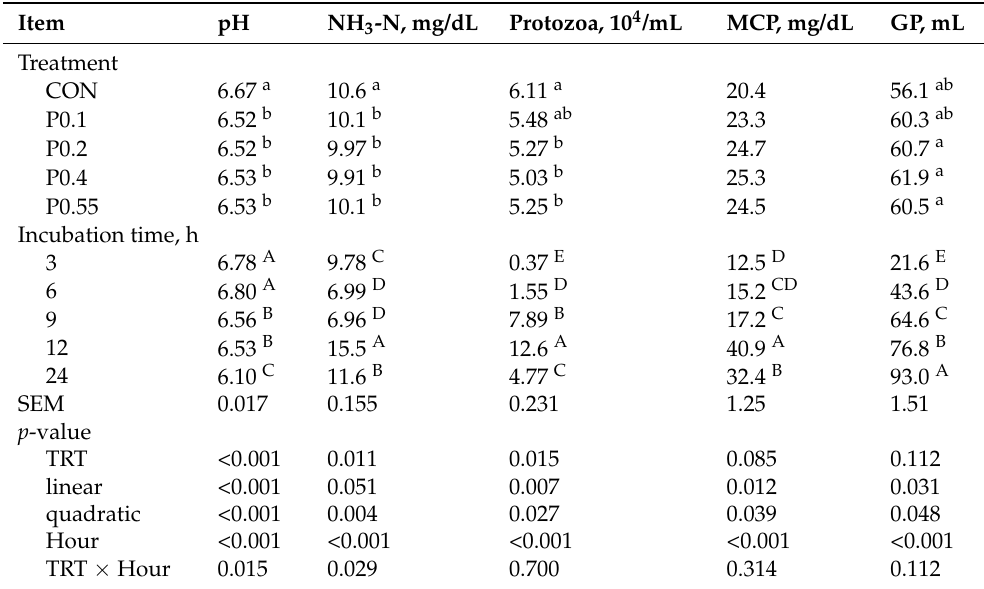
Table 3. The effect of NFP on in vitro ruminal pH, NH 3 -N, protozoa, MCP and GP within 24 h